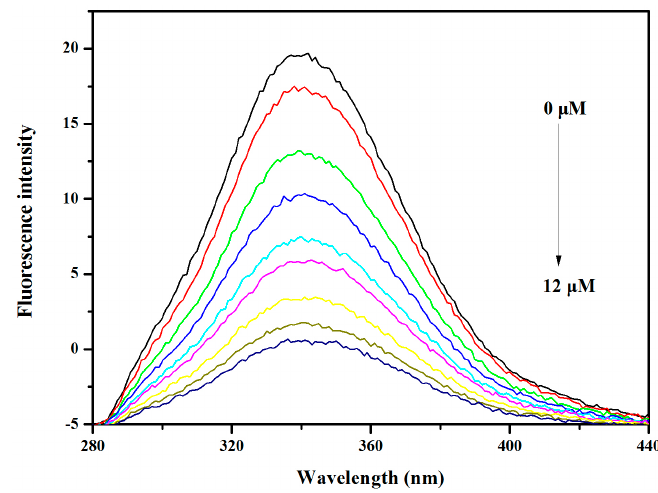
Figure 9. The fluorescence spectra of BSA (0.5 μ M) in the presence of different concentrations of V 18 (0, 1.33, 2.67, 4.00, 5.33, 6.67, 9.33, 10.67, 12 μ M) in PBS.